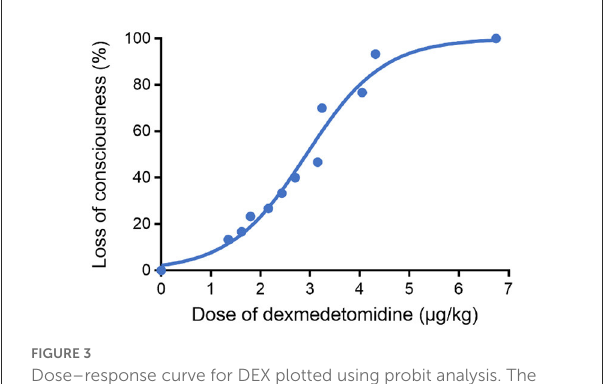
FIGURE3 Dose–response curve for DEX plotted using probit analysis. The ED50 and ED95 of DEX to achieve the state of “loss of